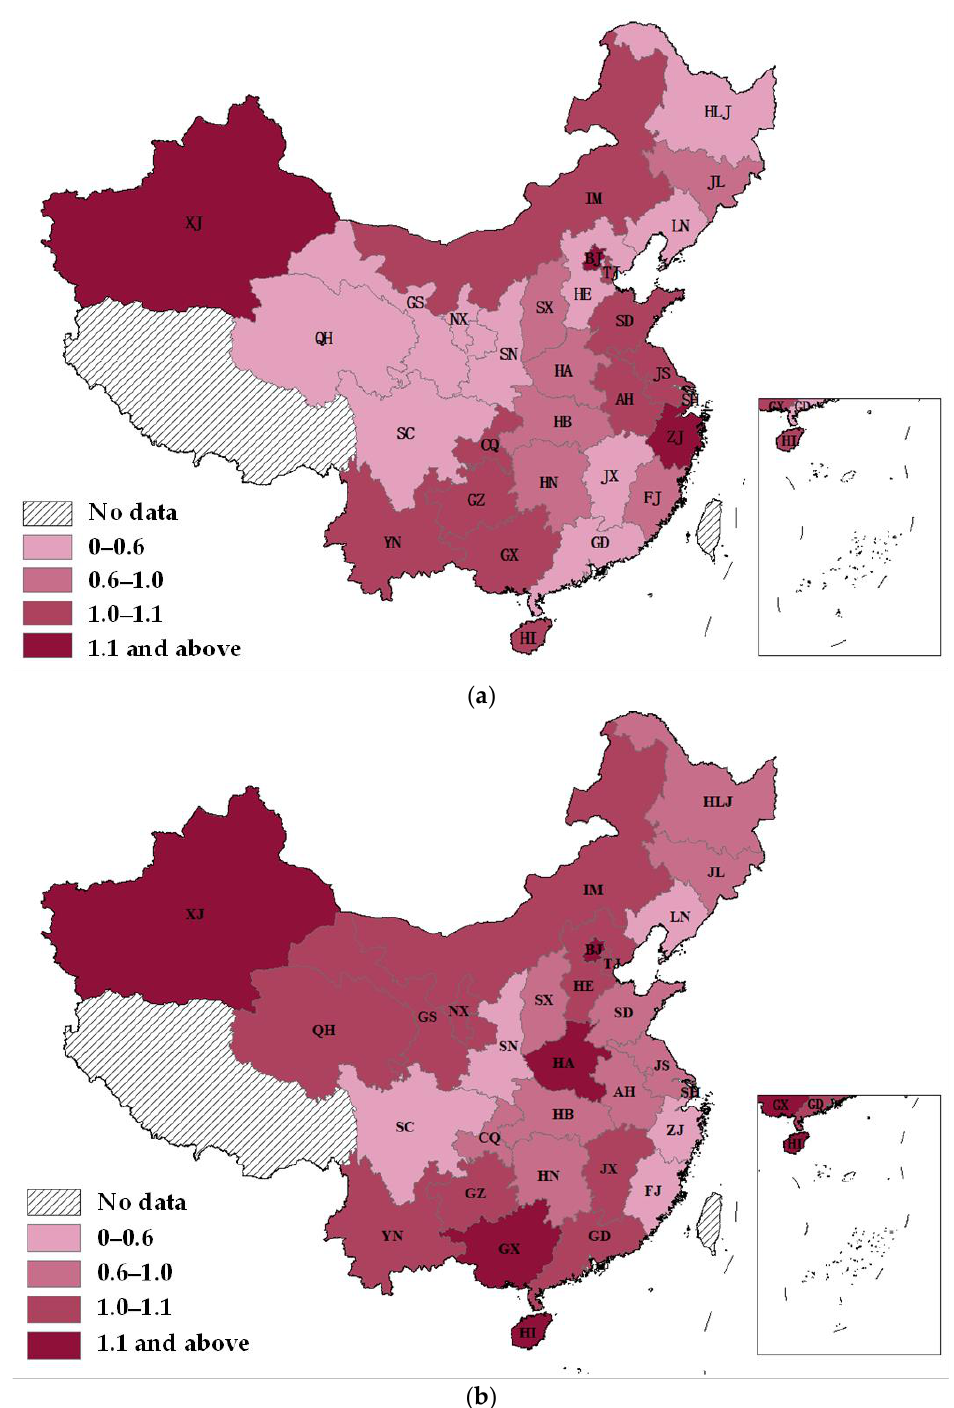
Figure 2. Spatial evolution of green innovation efficiency in China from 2009 to 2019. ( a ) 2009; ( b ) 2019. ( b )